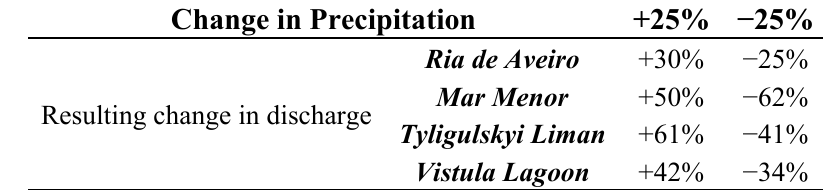
Table 6. Response of annual modelled discharge to changes in annual sum of precipitation by ±